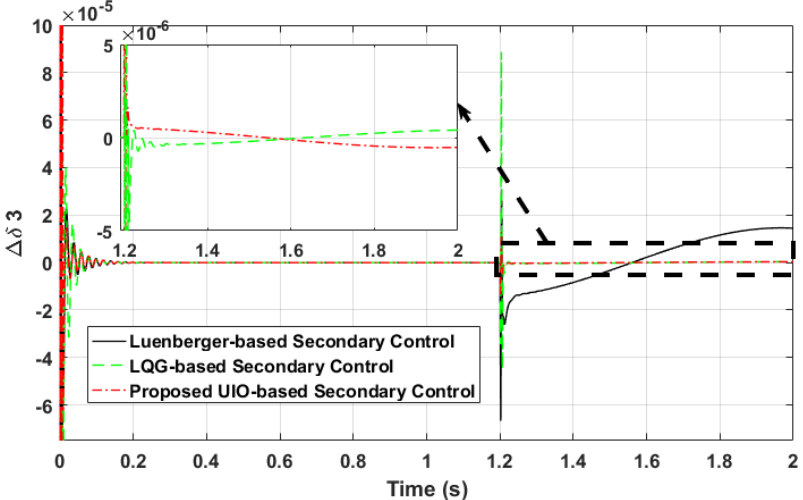
Figure 11. Third inverter angle δ 3 in scenario 2 (FDI into second inverter’s actuator).